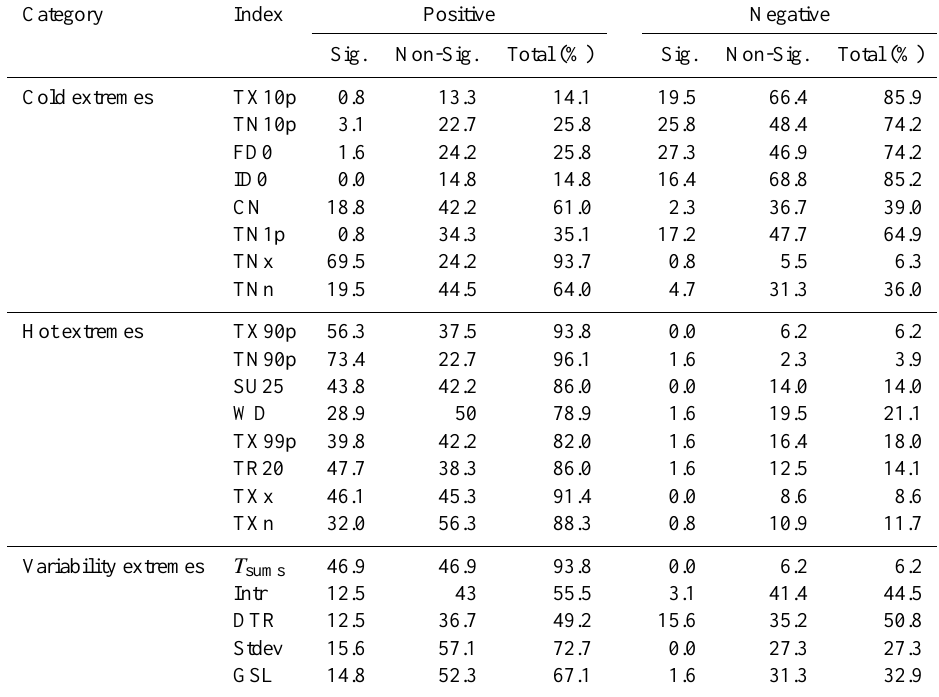
Table 2. Results of trend analysis for cold, hot and variability extremes (significance is assessed at the 95% level). Abbreviations of the indices correspond to those in Table